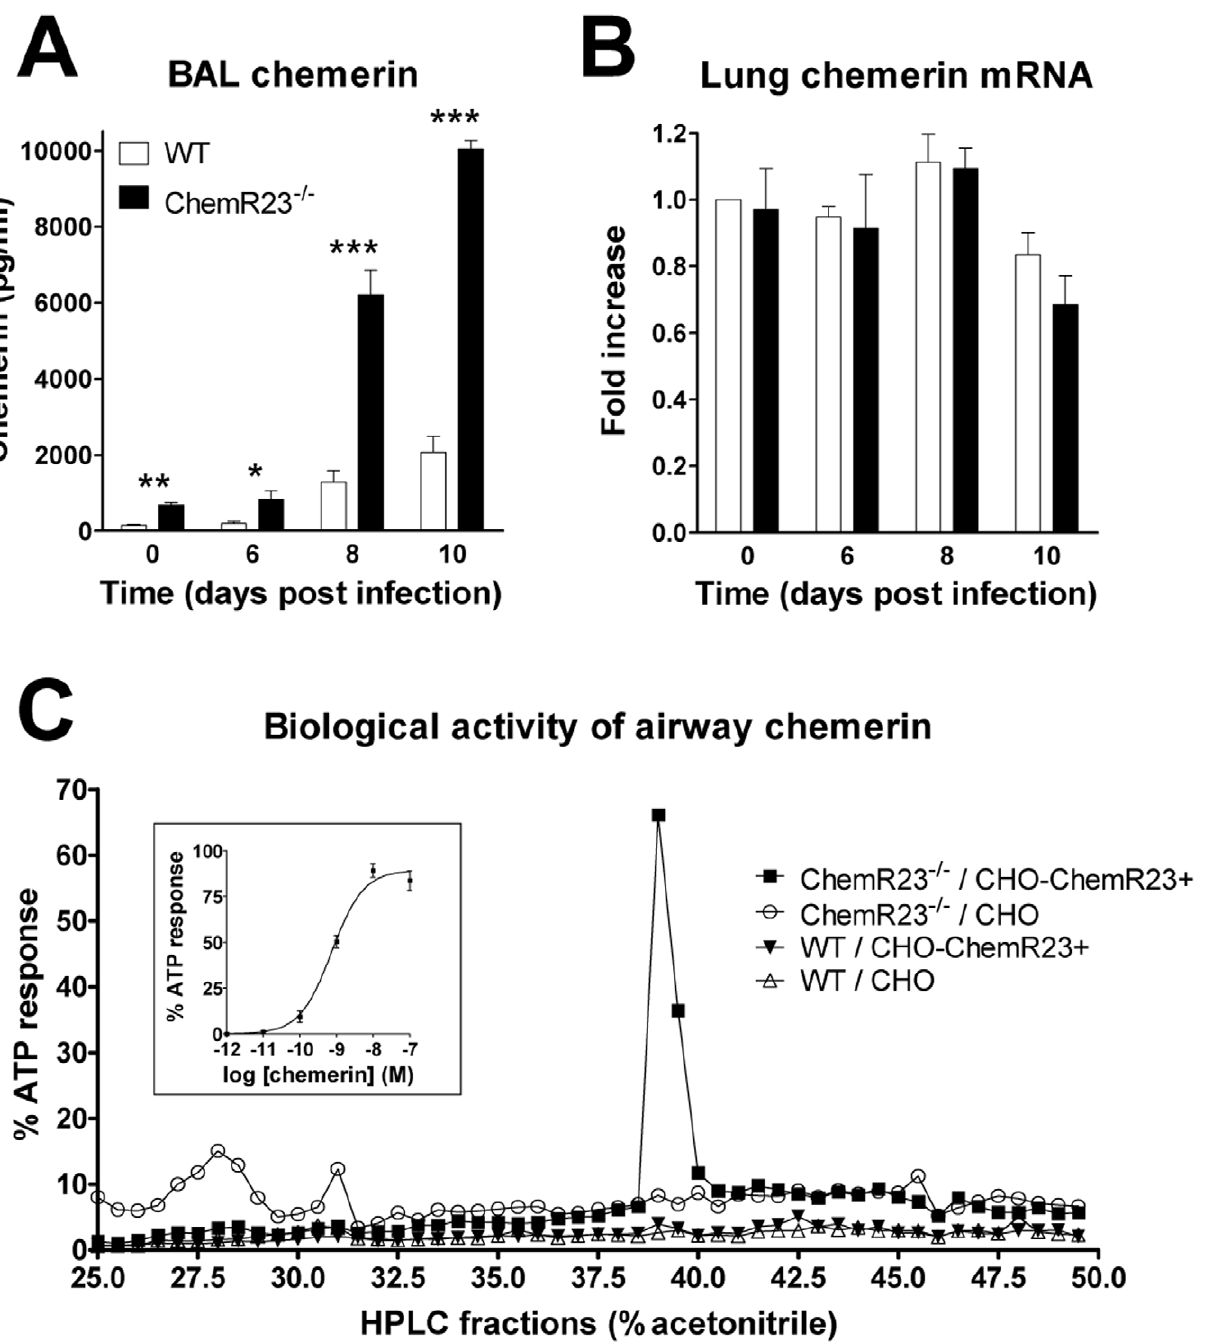
Figure 2. Increased chemerin levels in broncho-alveolar lavage fluid during PVM infection. ( A ) At selected time points after viral inoculation, chemerin levels were determined by ELISA in BAL fluids of ChemR23 2 / 2 and wild-type C57BL/6 mice. ( B ) Chemerin transcript levels were determined by quantitative RT-PCR. The data were normalized using two housekeeping genes (YWHAZ and CANX) as references, and reported to the chemerin transcript level in uninfected control mice. The displayed data are the mean 6 SEM for groups of minimum seven animals. ( C ) The biological activity of chemerin was measured in BAL fluids obtained at day 9 post-infection from wild-type (WT) and ChemR23 2 / 2 mice after a reverse phase HPLC fractionation (C18 column) using an aequorin-based intracellular Ca 2 + mobilization assay. The data shown are the activity of fractions (25 to 50% acetonitrile) normalized to the response to ATP upon testing on CHO-K1 cells expressing mouse ChemR23 (CHO-ChemR23 + ) or not (CHO). The functional response of mouse ChemR23-expressing CHO-K1 cells to recombinant mouse chemerin is shown as inset. Data are representative of three independent experiments. *, p , 0.05; **, p , 0.01; ***, p , 0.001.